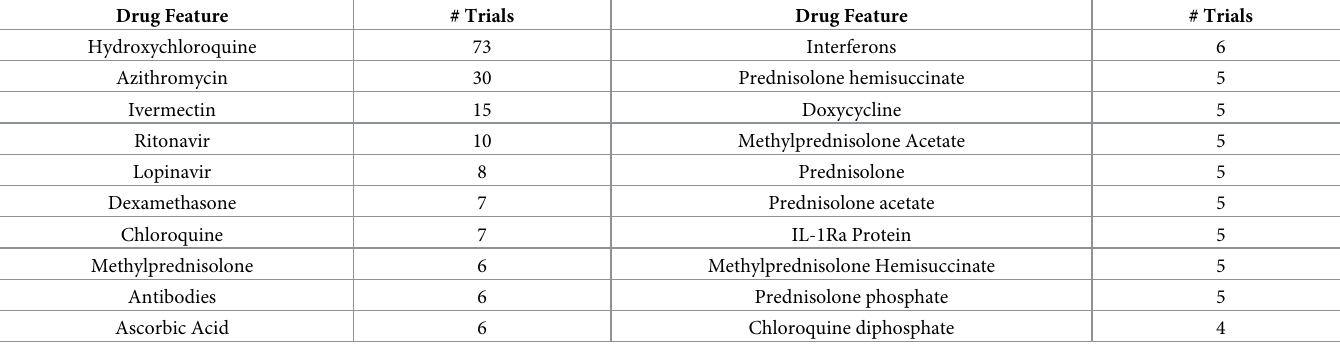
Table 3. Top drug features and the number of clinical trials with the drug intervention.